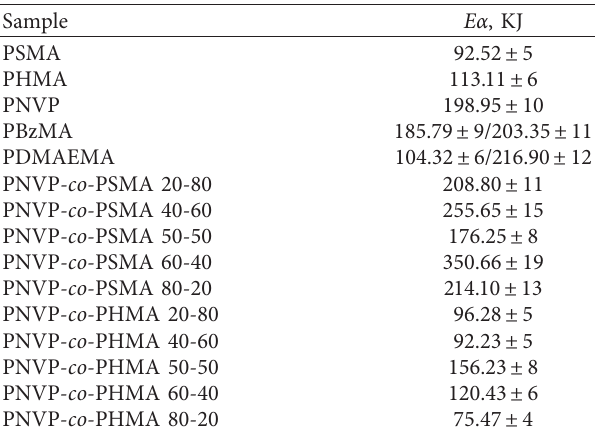
Table 2: Activation energies by the Kissinger method for the homopolymers and the statistical